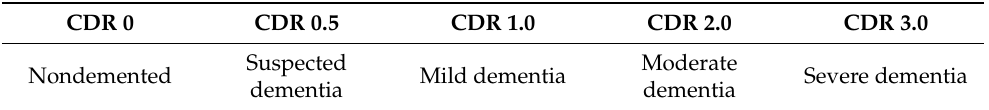
Figure 3. Samples of OASIS dataset. ( a ) AD. ( b ) NC. Table 1. Diagnostic criteria for CDR.